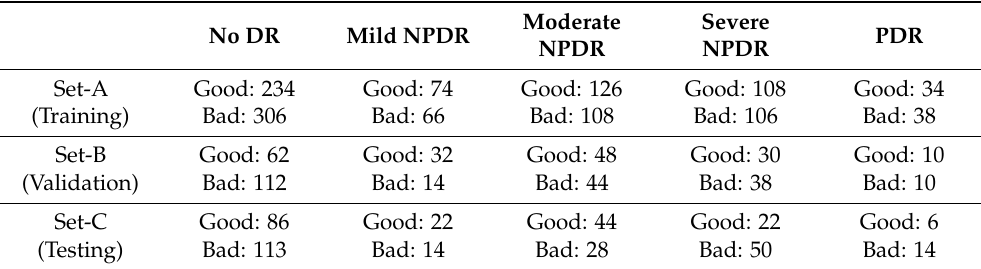
Table 3. The number of good and bad quality images in the training, validation, and test set stratified with respect to DR severity. DR: diabetic retinopathy, NPDR: non-proliferative diabetic retinopathy, PDR: proliferative